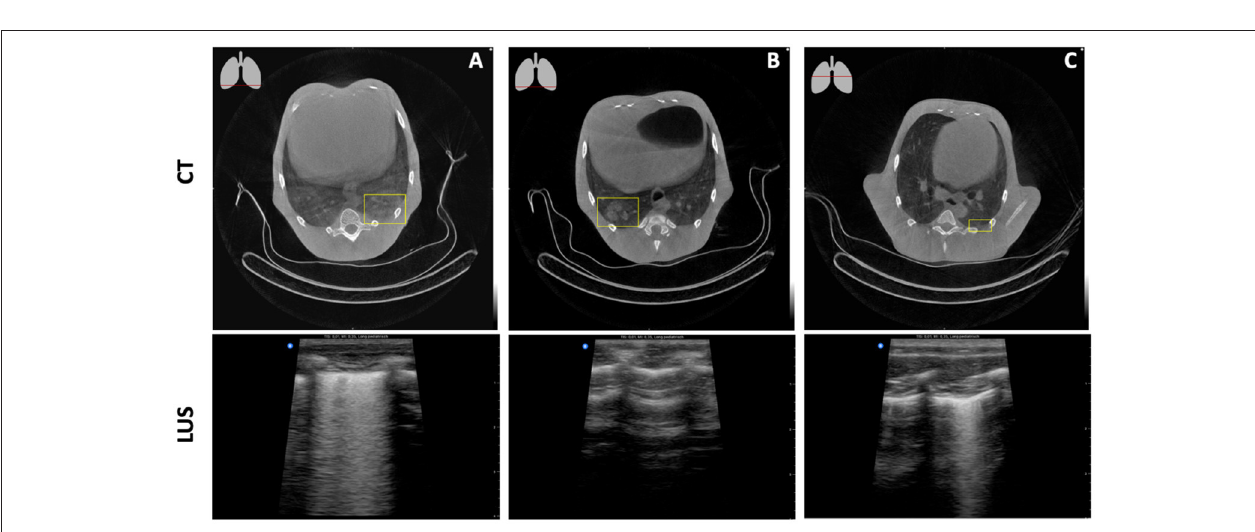
FIGURE 6 | Detectability of lung lesions with LUS. (A) A ground glass opacity on CT, attached to the pleural wall, leads to a multifocal B-line pattern on LUS. (B) A consolidation on CT which is almost attached to the pleural wall results in a seemingly healthy lung with LUS. (C) A multifocal B-line pattern on LUS resolves a minor consolidation attached to the pleural wall on